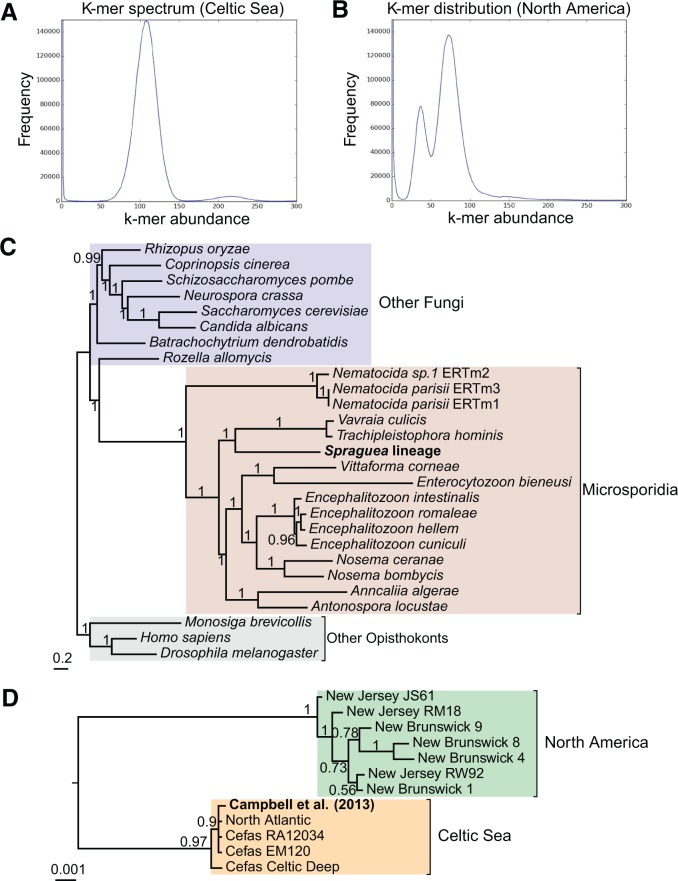
Evidence for a whole-genome duplication at the base of the North American clade. (A) The unimodal k-mer distribution for a representative Celtic Sea genome, that of the “Celtic Deep” isolate. (B) The k-mer distribution for a representative North American genome, the “New Brunswick 4” isolate. This distribution is bimodal, with peaks at 37× and 74×, suggesting the presence of both homozygous and heterozygous positions in North American genomes, but only homozygous positions in the Celtic Sea population. (C) A Bayesian phylogeny of the Spraguea lineage in the context of its microsporidian relatives and other opisthokont outgroups. Within-Spraguea relationships are collapsed due to the relatively short branch lengths in this region of the tree. (D) Relationships among Spraguea isolates, rooted using the tree depicted in (C). The earliest divergence splits the North American and Celtic Sea isolates with maximal posterior support (PP = 1), placing the ploidy increase at the base of the North American clade. These trees were inferred under the CAT + GTR model (Lartillot and Philippe 2004) in PhyloBayes-MPI 1.5a (Lartillot et al. 2013) using a concatenation of 23 single-copy orthologous protein-coding genes that share a congruent phylogenetic signal as determined by a hierarchical likelihood ratio test (Leigh et al. 2008).